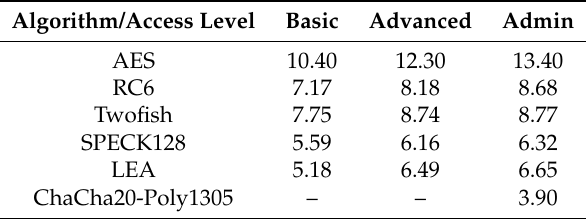
Table 3. Battery drain (mAh) in the ARMv7-a Samsung device. Algorithm/Access